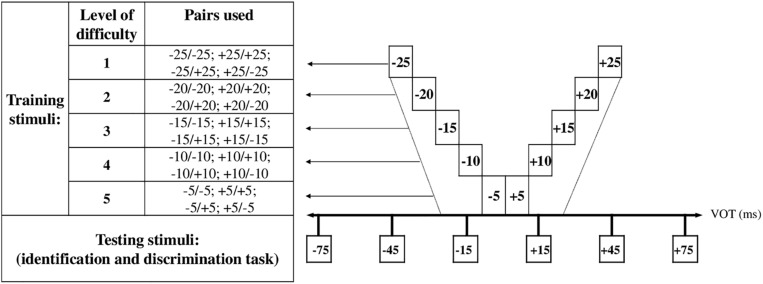
VOT values used in RapDys© for the identification and discrimination tasks (from Collet et al., 2012, Figure 1).